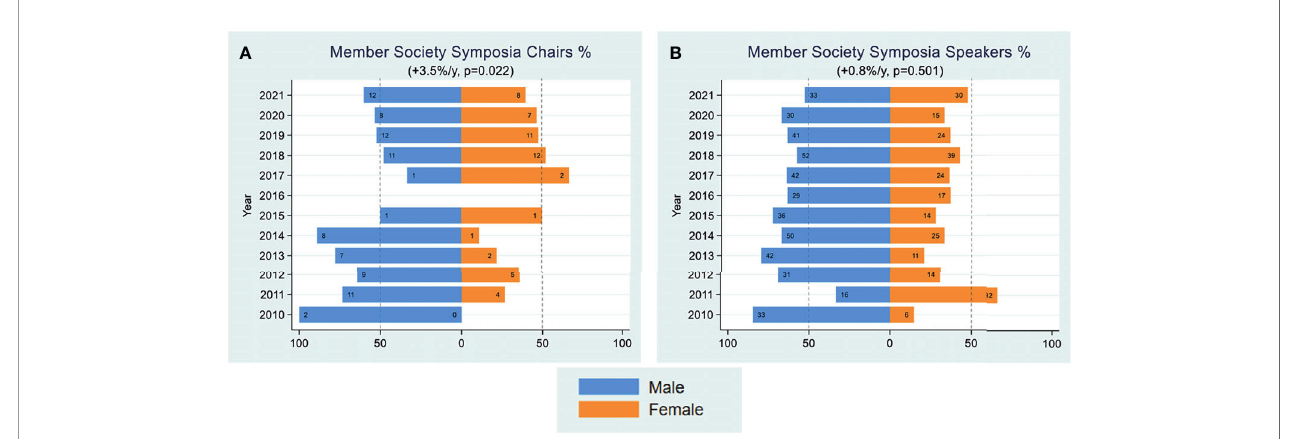
FIGURE 7 | Member Society Symposia Data. Yearly female percentages of member society symposia chairs (A) and member society symposia speakers (B) are shown over the period 2010-2021. Percentages were based on actual numbers subjects stating their gender. Average changes per year and p-values (shown in parentheses) were estimated by the slope coef fi cient from a simple linear regression model. Gender data for member society symposia chairs was not collected for 2016. The dotted line represents 50% as a point of reference for parity.